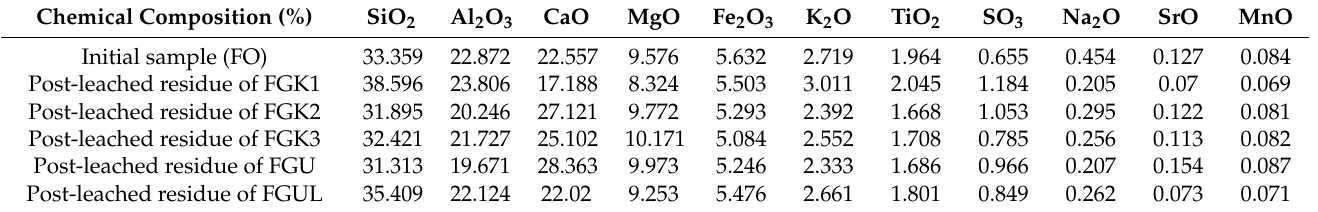
Table 3. Chemical Compositions of the Original Coal Gangue Sample and its Post-Leached Resi- dues.